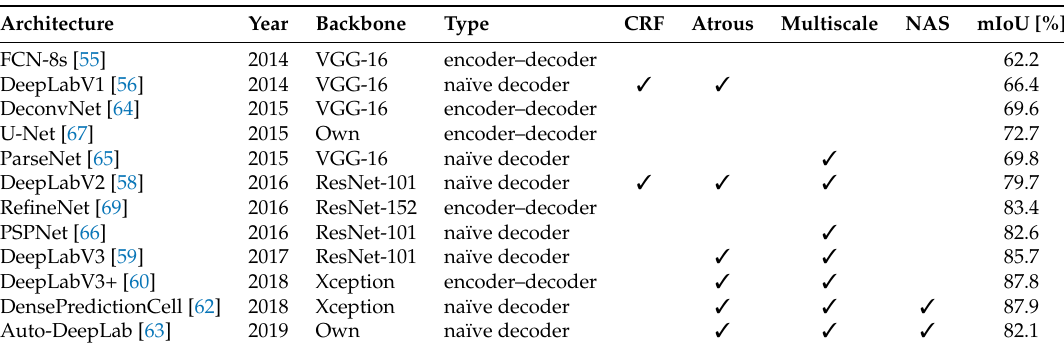
Table 3. Summary of the evolution of convolutional neural networks (CNNs) for image segmentation and the above discussed cornerstones. The Backbone is the reported CNN used for feature extraction; CRF describes the use of a conditional random field for refinement; Atrous shows the application of atrous convolution; Multiscale shows if a dedicated module that handles multiscale feature extraction, e.g. ASPP, is used; NAS means that parts of the architecture are drafted by using neural architecture search; and mIoU describes the performance on the PASCAL-VOC 2012 dataset for image